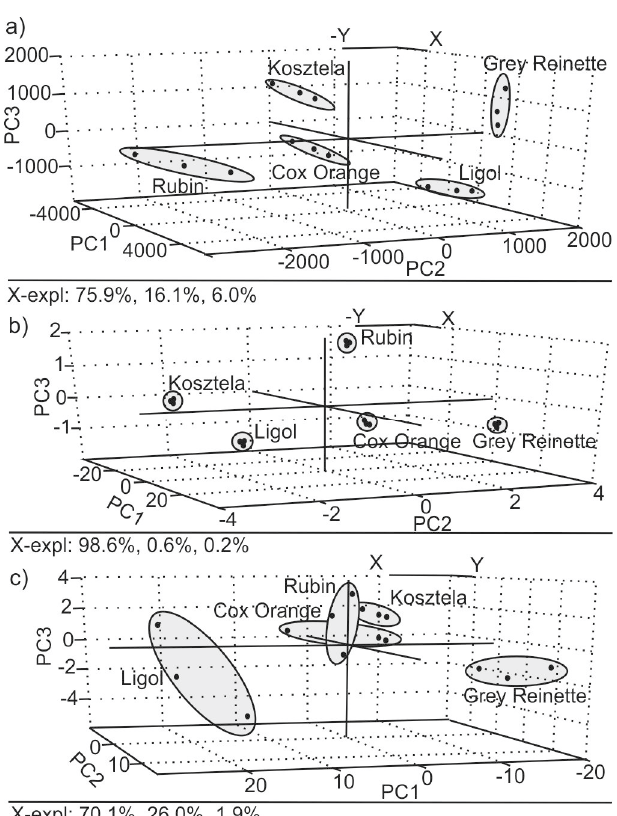
Figure 4. Principal component analysis scores plot corresponding to the classification of the five nalewka liqueurs using ( a ) e-tongue composed by an array of carbon paste electrodes modified with metal phthalocyanines; ( b ) using color parameters: L, a*, b*, C*, h* and BI; and ( c ) Raman spectra. UV-Visible spectra were used to obtain the CIELab coordinates (L, a*, b*, C, H and BI) giving global color information from the studied samples that was used to discriminate liqueurs by means of